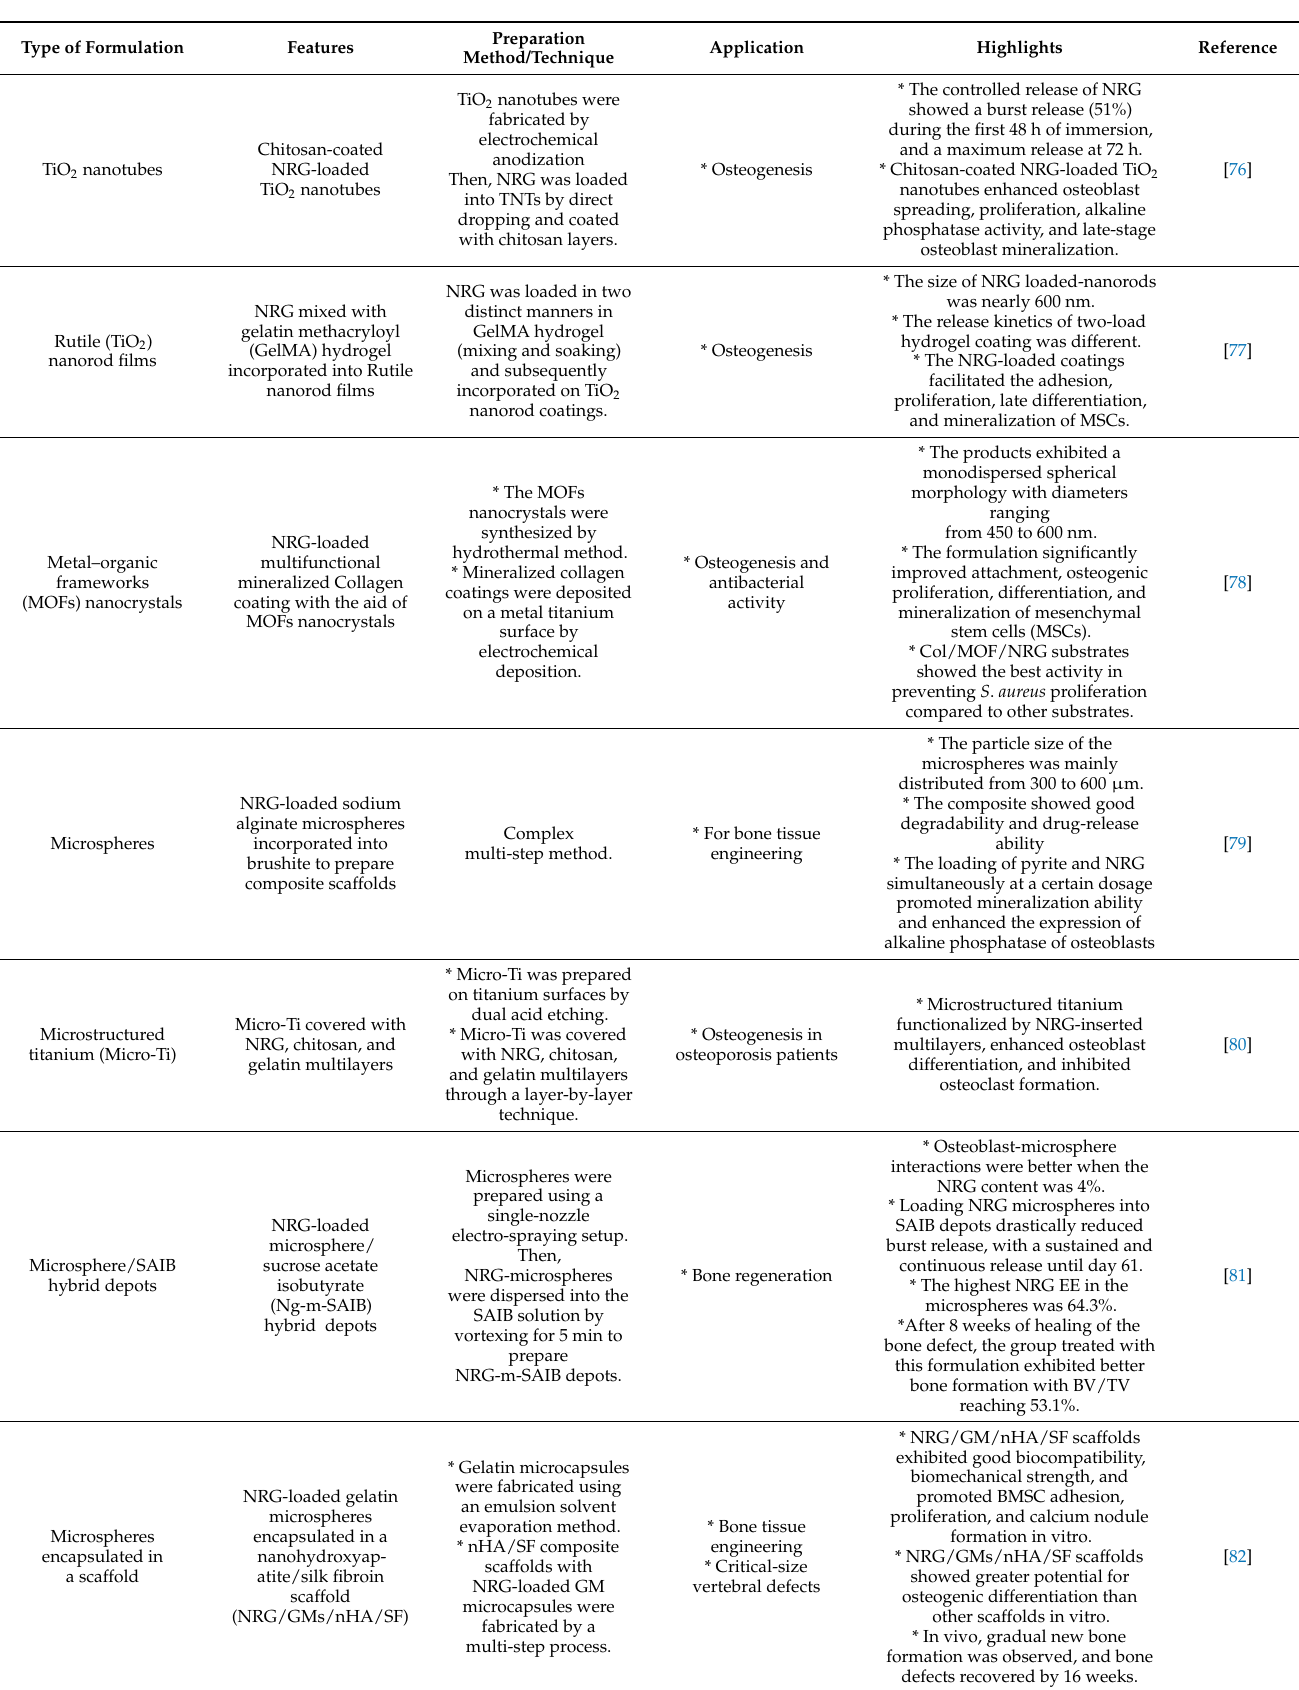
Table 1. Other nanoformulations designed for the delivery of